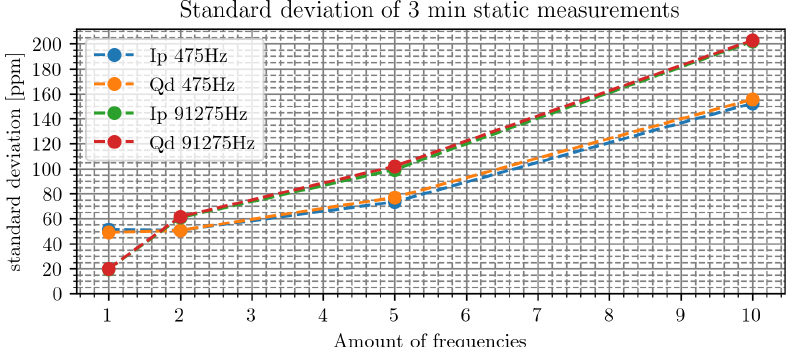
Figure 6. Results of Test 4. The calculated standard deviation for 475 and 91275Hz is shown with different numbers of transmitted frequen- cies. Note that when the number of frequencies equals 1, it is the standard deviation on the frequency itself without any other transmitted frequencies. The additional frequencies between 475 and 91275Hz are linearly